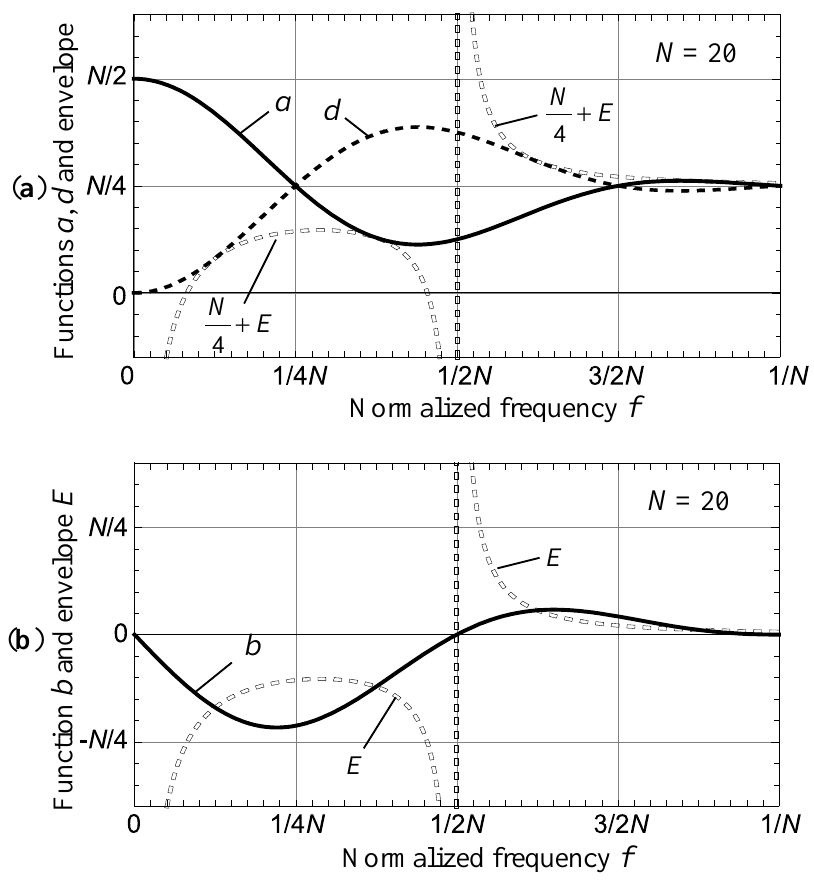
Figure 4. AC leakage gains of Equation (2) as functions of the normalized frequency f below f = 1/ N ( a ) matrix elements a and d and ( b ) matrix element b